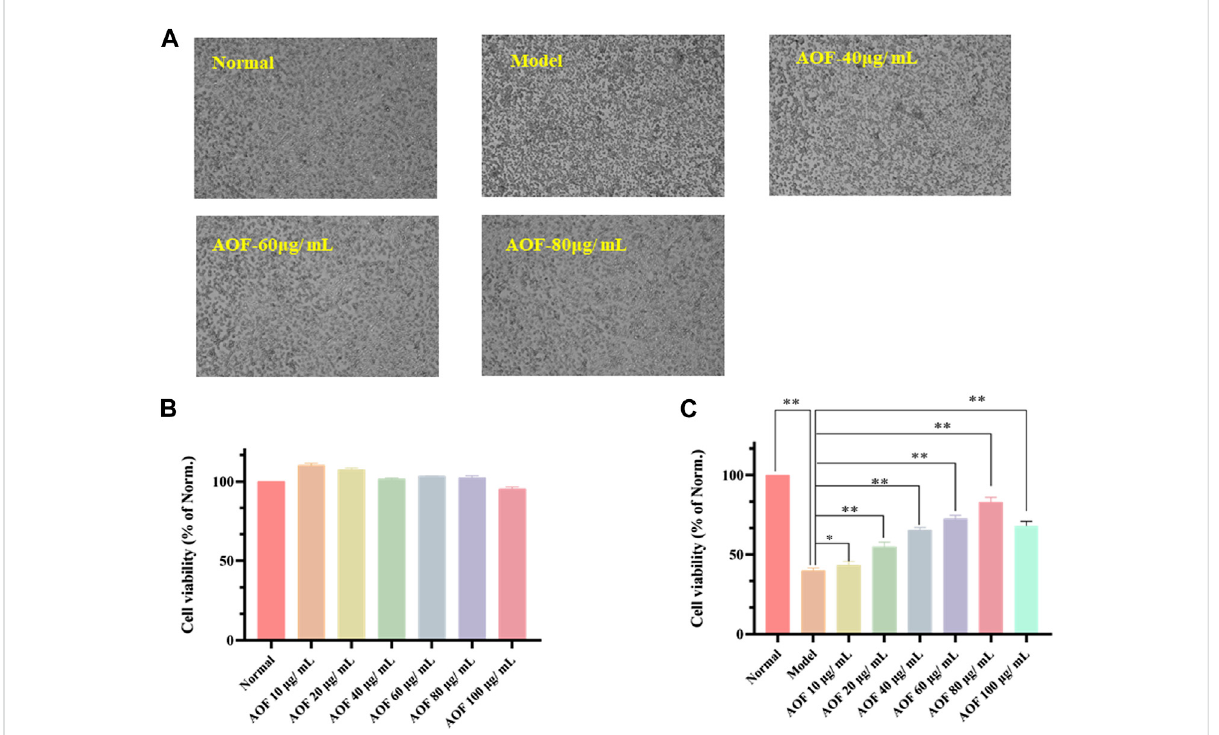
FIGURE 6 Protective effects of AOF on the cell viability of H 2 O 2 -stimulated PC12 cells (A) The represented cell morphology of PC12 cells with different treatment (B) Effects of AOF on cell viability of normal PC12 cell (C) Effects of AOF on cell viability of H 2 O 2 -stimulated PC12 cells under different concentration. The values were represented as the mean ± SD ( n = 3). * p < 0.05, ** p < 0.01 vs the model